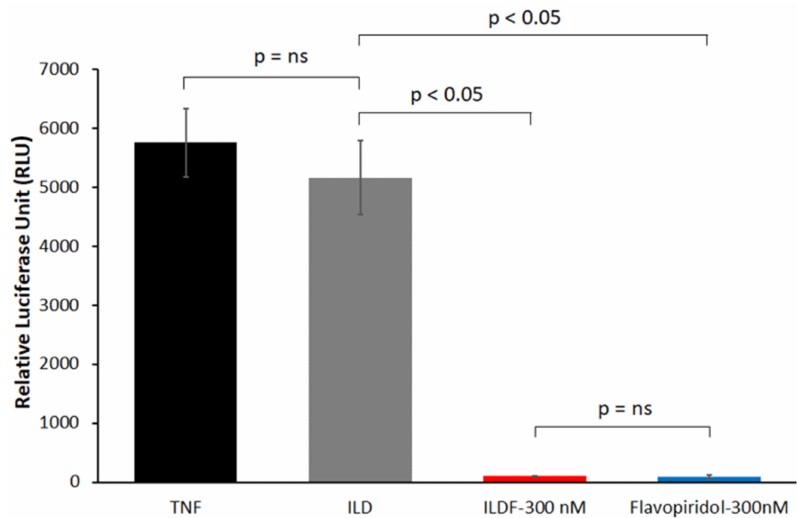
Figure 11. Bioactivity of Flavopiridol in ILDF particles measured by luciferase assay. Released Flavopiridol from ILDF particles and blank ILD particles were assessed by measuring the suppression of luciferase activity in HEK-Luc reporter cells stimulated with TNF- α (0.6 nM). Experiments were performed in triplicate (N = 3), and results were reported as mean ±